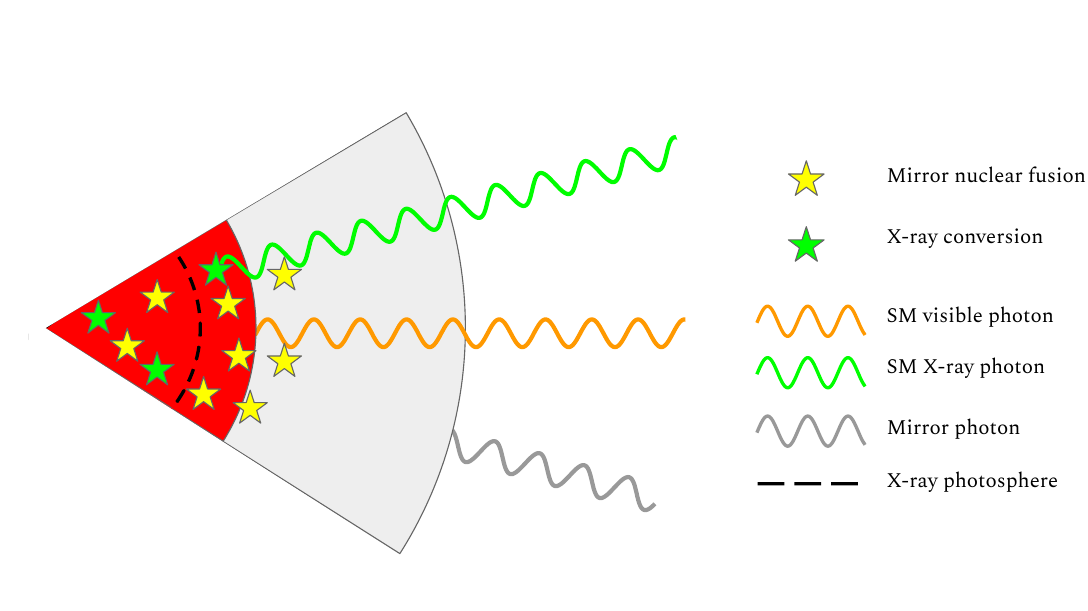
Figure 2 . Interior of a Mirror Star. Mirror matter is shown grey, captured SM matter in red. The star symbols illustrate why we expect to see X-rays from the Mirror Star core; mirror fusion reactions (yellow stars) produce energy and high energy photons, however these do not escape the star because they only occur in the core. X-ray conversion (green stars) occurs at a constant rate per unit mass of the SM nugget, which is small enough to be contained within the Mirror Star core, so conversions happening near the surface of the nugget will escape the star. Also shown is the (cid:15) 2 suppressed surface signal, which is expected to be negligible compared to the X-ray and thermal nugget